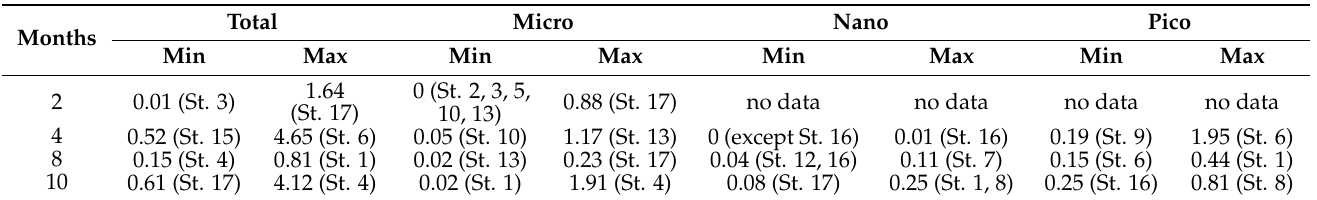
Table 2. Range of total chlorophyll- a concentrations ( µ g/L), microplankton (>20 µ m), nanoplankton (3–20 µ m), and pico-plankton (<3 µ m) in the Korea South